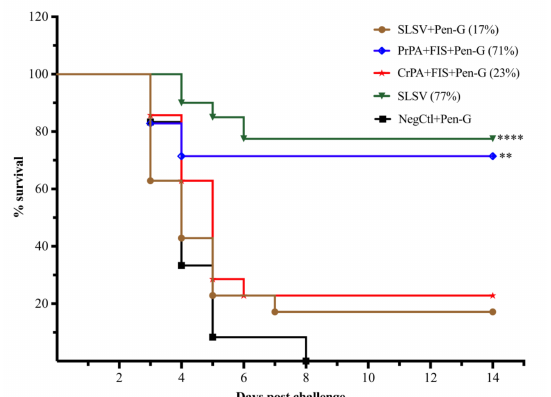
Figure 8. Mice survival curve following passive in vivo transfer of purified IgG from sera from cattle to A / J mice. The A / J mice were lethally challenged with approximately 2.16 × 10 5 B. anthracis 34F2 spores. The polyclonal IgG are from sera of cattle vaccinated twice (week 0 and 3) with either PrPA + FIS + Emulsigen-D ® / Alhydrogel ® plus Pen-G, CrPA + FIS + Emulsigen-D ® / Alhydrogel ® plus Pen-G, SLSV plus Pen-G, SLSV alone groups and NegCtl groups (Emulsigen-D ® / Alhydrogel ® plus Pen-G). The survival rate in Log-rank (Mantel–Cox) test was compared to NegCtl group. The significant values between groups are presented as **** p < 0.0001, *** p < 0.001, ** p < 0.01. Purified recombinant protective antigen: PrPA; Crude recombinant protective antigen: CrPA; Formalin inactivated Bacillus anthracis spores: FIS; Penicillin-G: Pen-G; Sterne live spore vaccine: SLSV; Negative control: NegCtl (Emulsigen-D ® / Alhydrogel ® plus